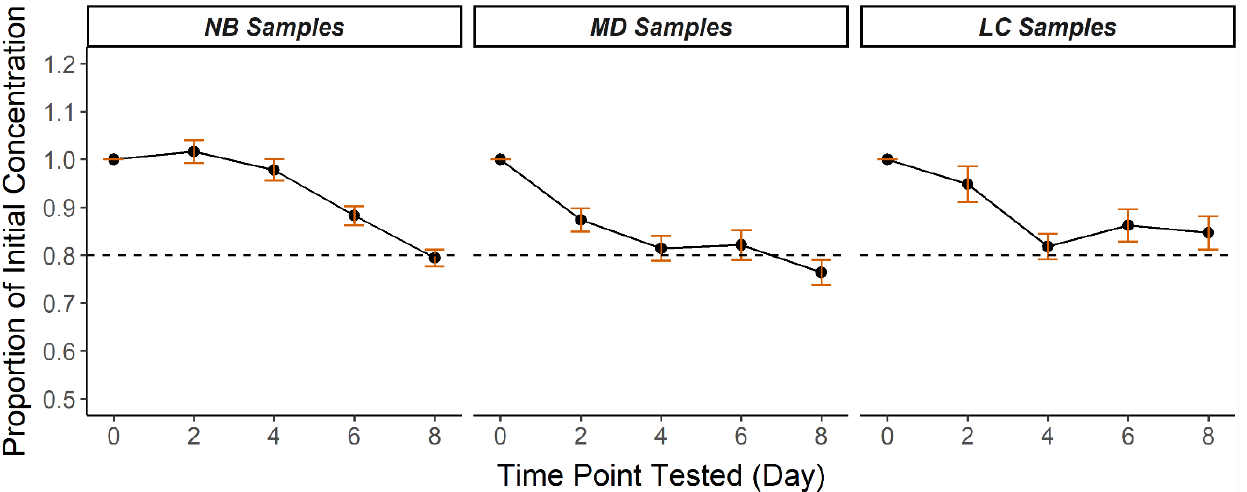
Figure 2. Mean CK ‐ MM recovery over 8 days in high heat and humidity in three DBS specimen types (NB, MD, LC). Results are calculated mean proportions of initial CK ‐ MM concentrations at each timepoint. Error bars represent ± standard error of the mean. Dotted lines represent 80% of initial concentration.